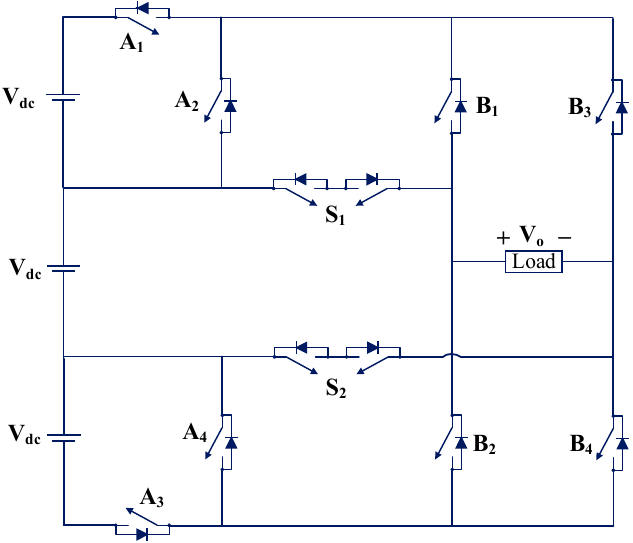
Figure 27. Single-phase seven-level FT MLI (TP30) [62].